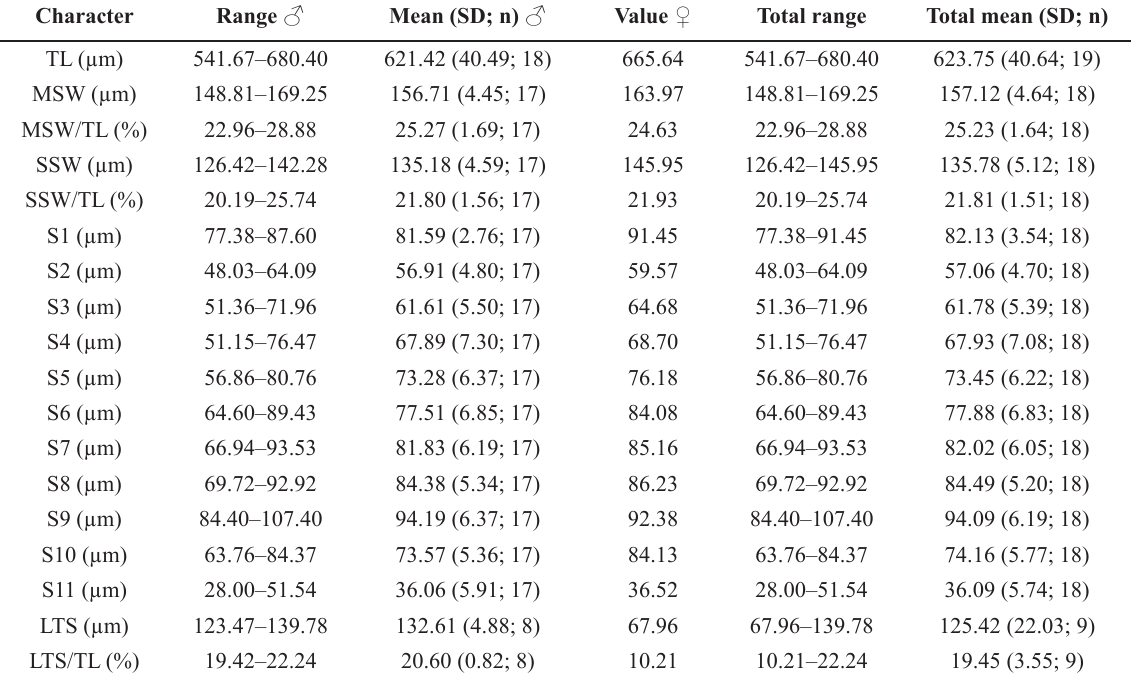
Table 1. Measurements of 19 adult specimens of Setaphyes algarvensis sp. nov. (18 ♂♂, 1 ♀). Abbreviations: LTS = lateral terminal spine length; MSW = maximum sternal width (measured at segment 7); S = segment length (followed by number of corresponding segment); SD = standard deviation; SSW = standard sternal width (measured at segment 10); TL = total length.